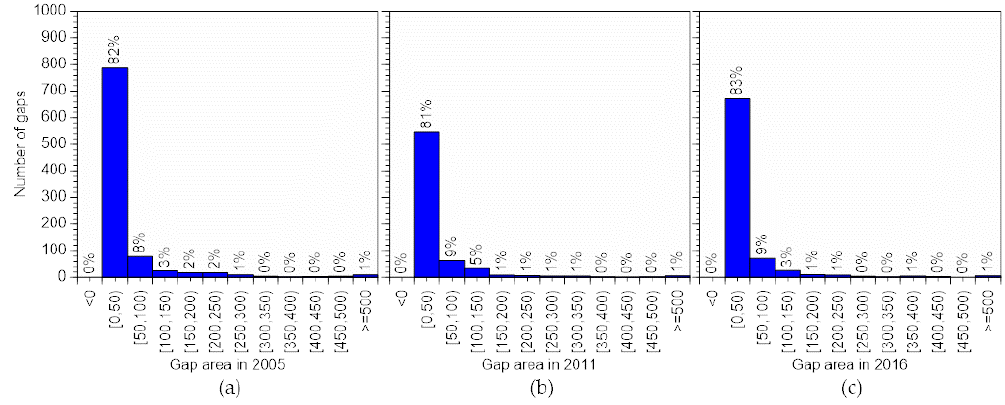
Figure 5. Number of gaps by area class. ( a ) Gaps in 2005; ( b ) gaps in 2011; ( c ) gaps in 2016. Changes in gaps over each of the three periods are summarized in Table 4. Number